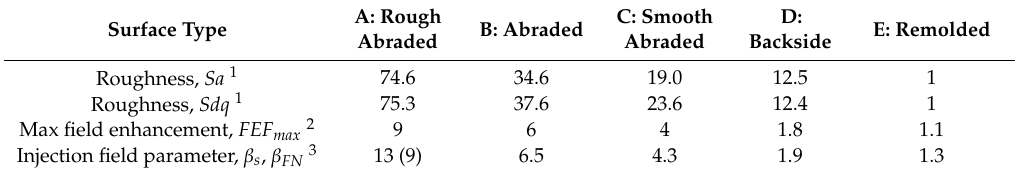
Table 1. As the unmodified Equation (8) was used, neglecting the image charge e ff ect, as in Equation (3), the β -parameters were selected to closely match in the range of the current density (10 giving a poorer fit outside of this region, as displayed in Figure 5C (bottom left). For the remolded surface, a beta parameter of 1.3 was found to give the best fit to the averaged injection current